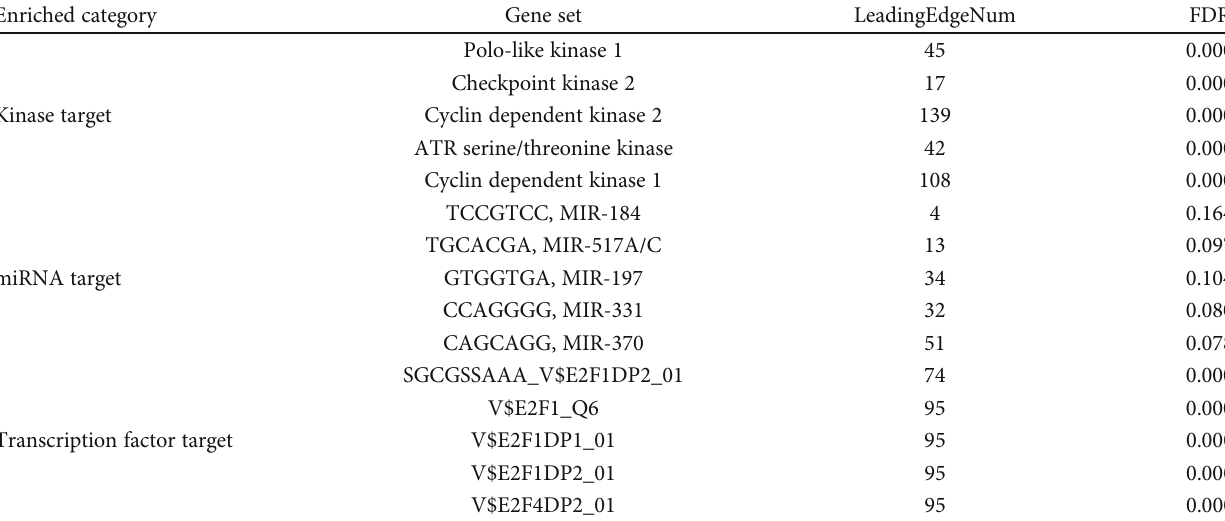
Table 2: The kinase, miRNA, and transcription factor-target networks of DHX37 in LIHC and LUAD (LinkedOmics). Enriched category Gene set